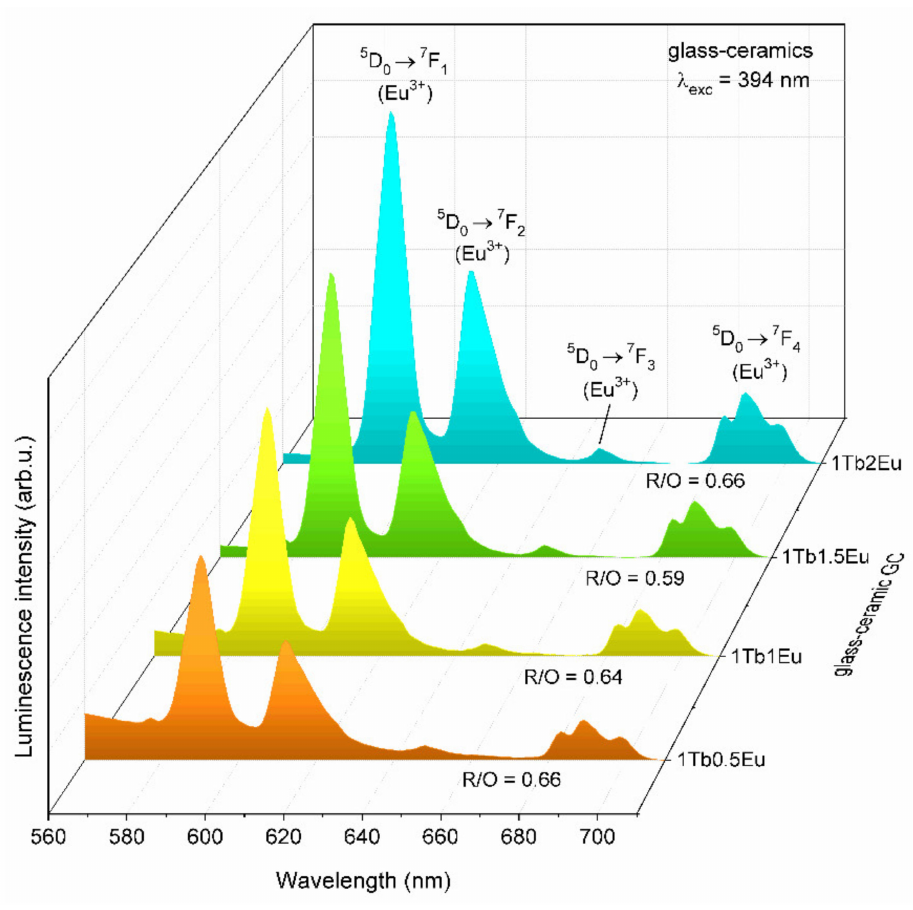
Figure 5. The emission spectra of GC 1TbxEu glass-ceramics co-doped with Tb 3+ /Eu 3+ ions recorded at λ exc = 394